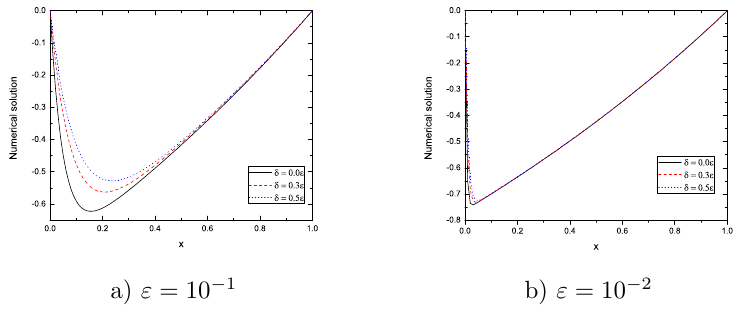
Figure 2. Numerical solution for Example